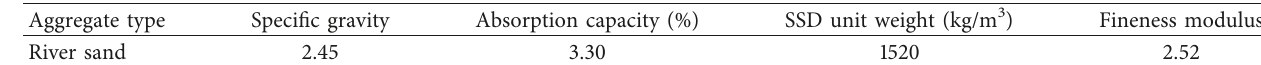
Table 3: Properties of fine